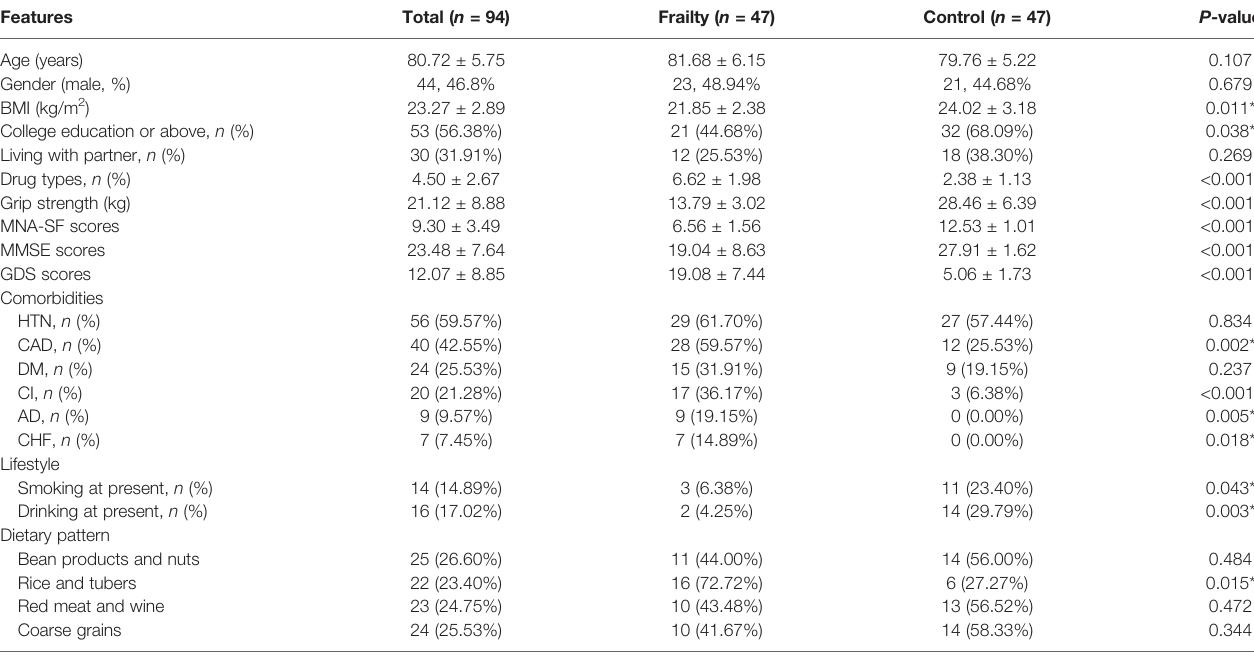
Smoking at present, n (%)